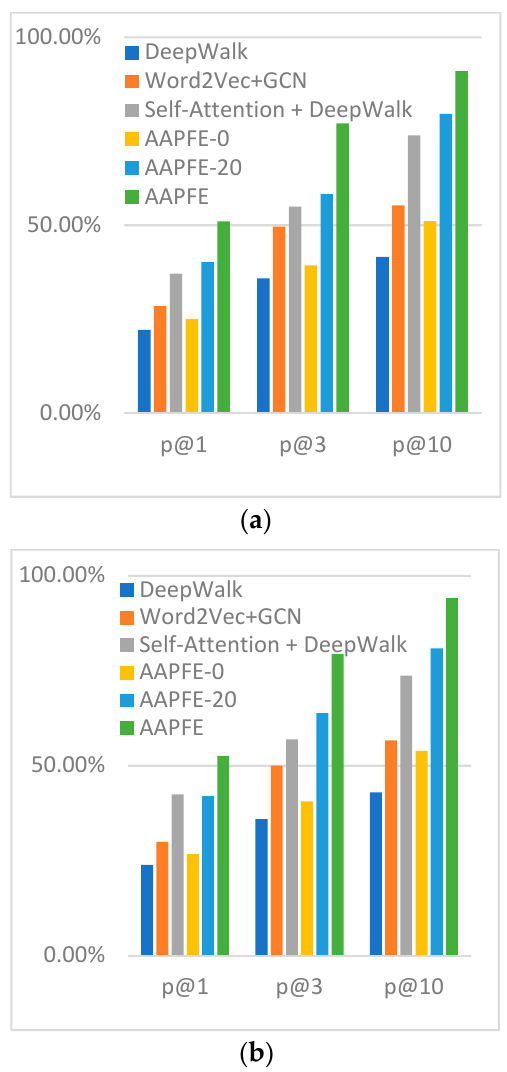
Figure 11. Comparison of different model compositions and pretraining epochs: ( a ) p@N in the disassembling set; ( b ) p@N in the compiling set.